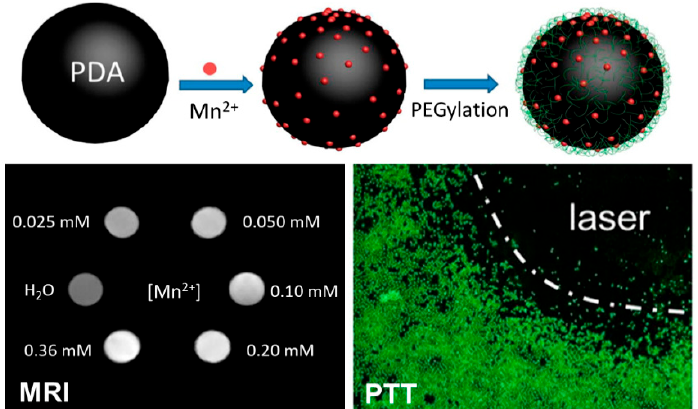
Figure 7. Schematic illustration of the fabrication of PEGylated Mn 2 + − PDA nanoparticles (PMPDA NPs). MRI in vitro assay of PMPDA NPs: T1-weighed images of water and PMPDA NPs in aqueous solution at di ff erent concentrations of Mn 2 + ions and fluorescence microscopy images of HeLa cells stained with calcein AM after treatment with both PMPDA NPs and 10 min of laser irradiation. Reproduced with permission from [69]. Copyright American Chemical Society, 2015.